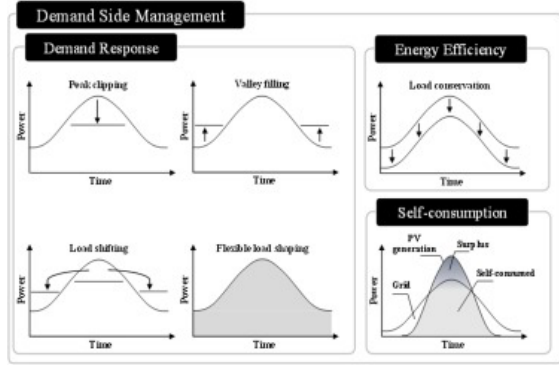
Fig. 3. Demand Side Management strategies for CE (Alskaif et al.